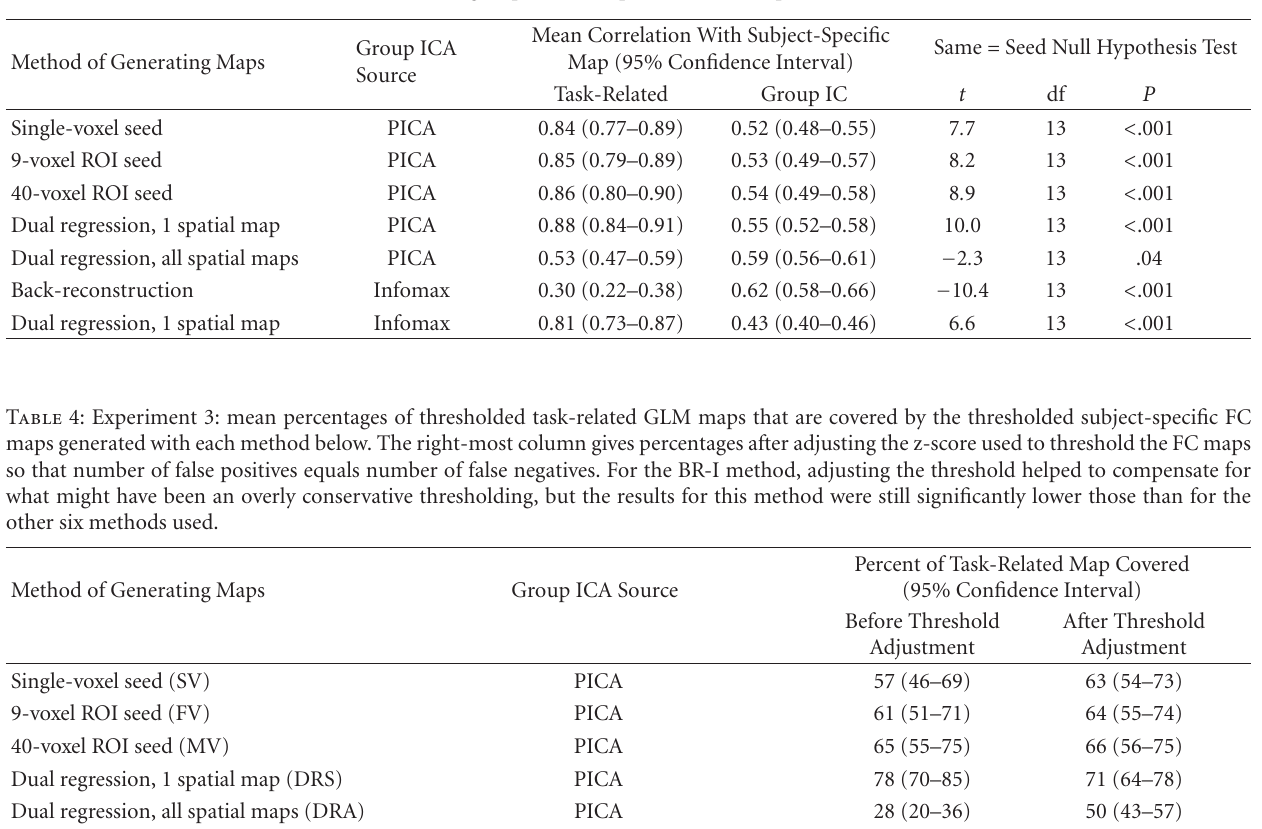
Table 3: Experiment 3: mean correlations of sbject-specific FC spatial maps with (1) the task-related GLM map for the same subject (“Task- Related” column) and (2) the group IC of interest (“Group IC” column). Results of a paired t -test comparison of the mean correlations are shown in the rightmost columns. Higher correlations with the task-related maps than with the group IC of interest are an indication that the results reflect the individual-subject data without being overly biased by spatial features of the group IC. The group ICs were generated with PICA or Infomax. These results were based on group ICAs that produced 14 components.